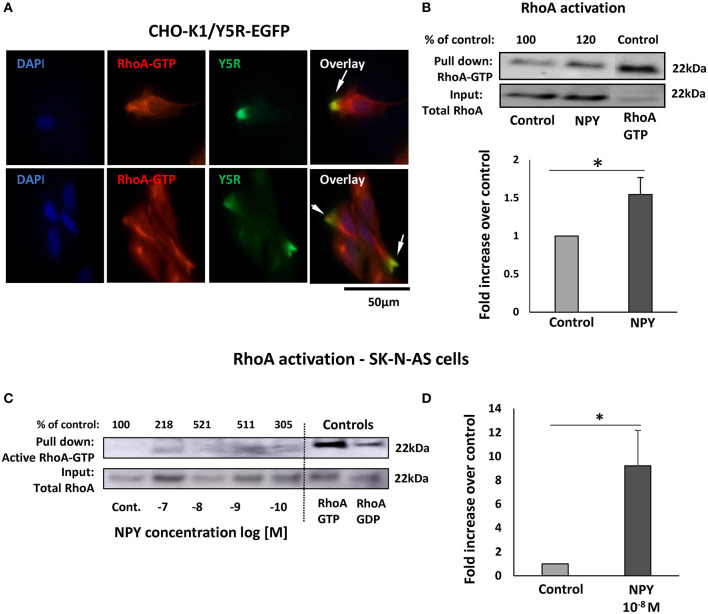
The NPY/Y5R pathway activates RhoA. (A) Immunocytochemistry with anti-Y5R (green) and anti-RhoA-GTP (red) antibodies in CHO-K1/Y5R-EGFP cells. (B) RhoA pull-down assay in CHO-K1/Y5R-EGFP cells treated with NPY (10−7 M). (C) RhoA pull-down assay in SK-N-AS NB cells treated with NPY (10−10-10−7 M). (D) Quantitative analysis of RhoA activity measured by a pull-down assay in SK-N-AS cells treated with NPY at a concentration of 10−8 M. (C,D) *p < 0.05 by t-test; mean ± SEM from three independent experiments.